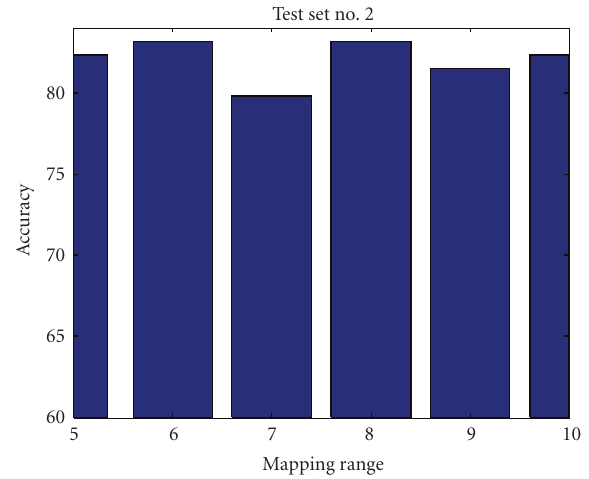
Figure 12: Mapping range impact on accuracy for test set number 4.